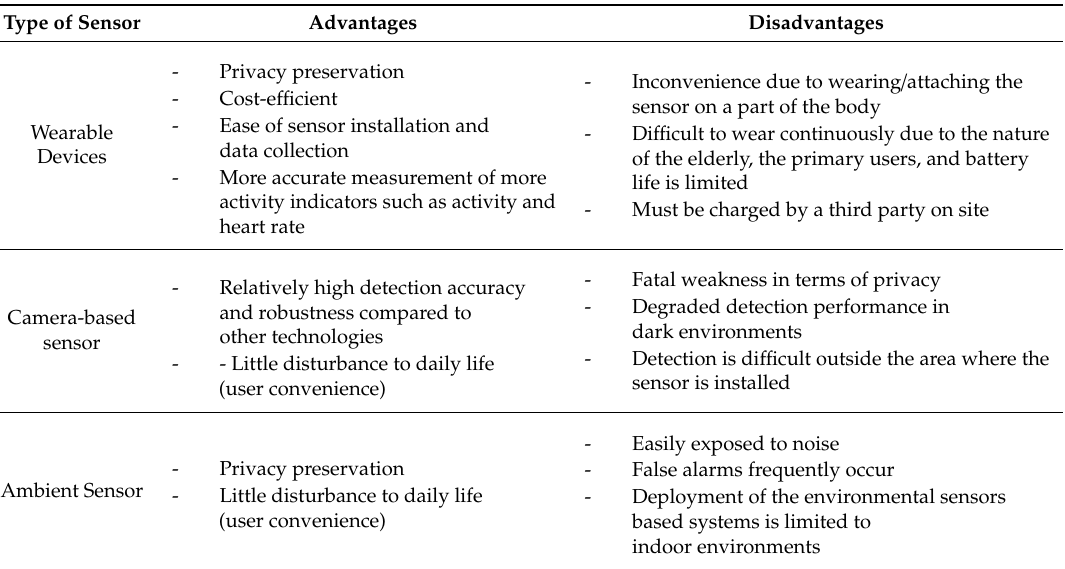
Table 1. Advantages and disadvantages depending on sensor